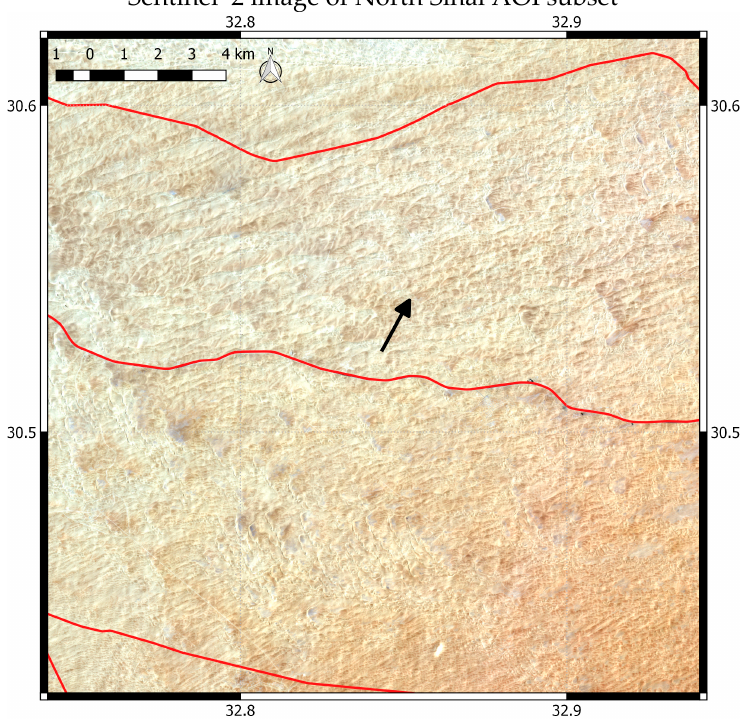
Figure 9. Sentinel–2 image of the same area as in Figure 7. The image was acquired on 2 August 2019 (roughly in the middle of the Sentinel–1 time series). It is displayed in true colour, bands 4,3,2 as red, green, and blue, respectively. Overlaid in red are the available OSM roads for this area. Contains modified Copernicus Sentinel–2 data 2020.